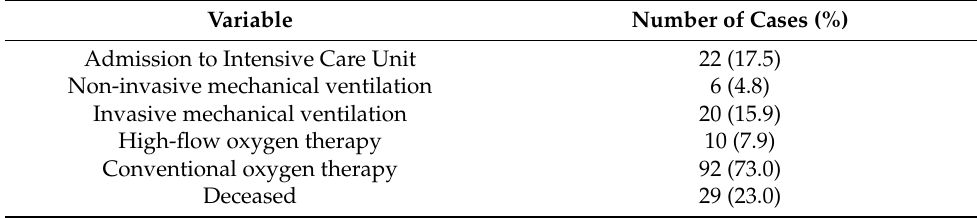
Figure 1. Scatter plots with error bars of selected variables in healthy controls, patients COVID-19 negative and COVID-19 positive. Results are given as means and standard error of the mean (SEM). Statistical analyses were performed using the Mann-Whitney U test. Table 2. Selected clinical variables in COVID-19 positive